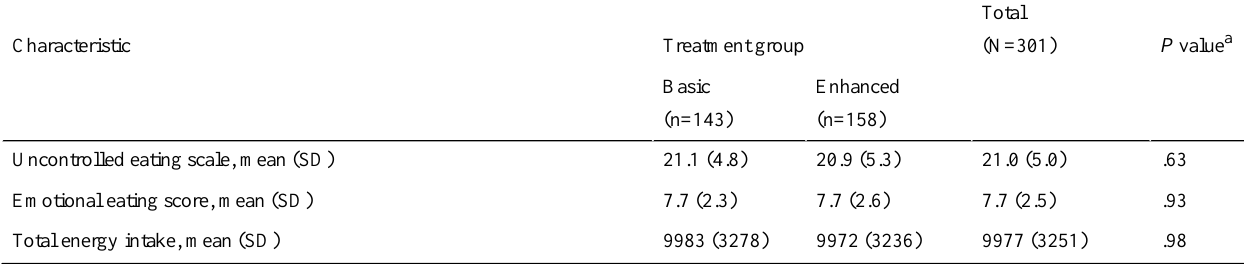
a P values are from ANOVA for continuous measures and from a chi-square tests for categorical